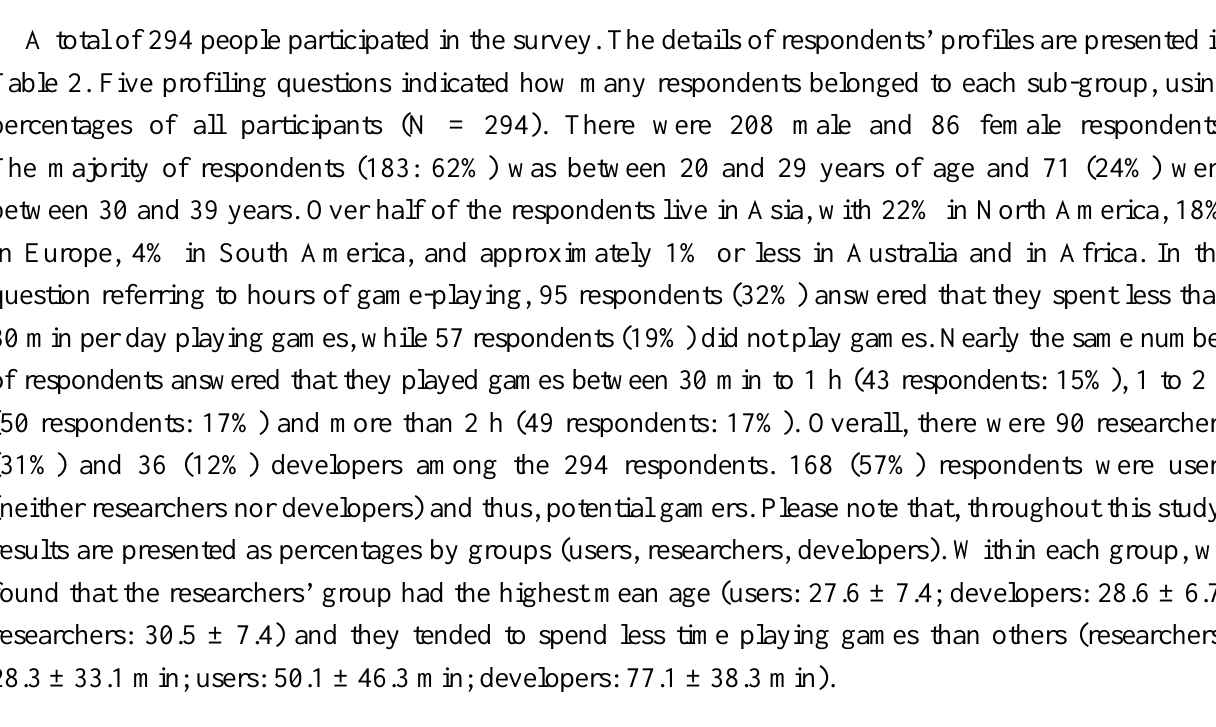
Table 2. Profile records. A total of 294 respondents participated in the